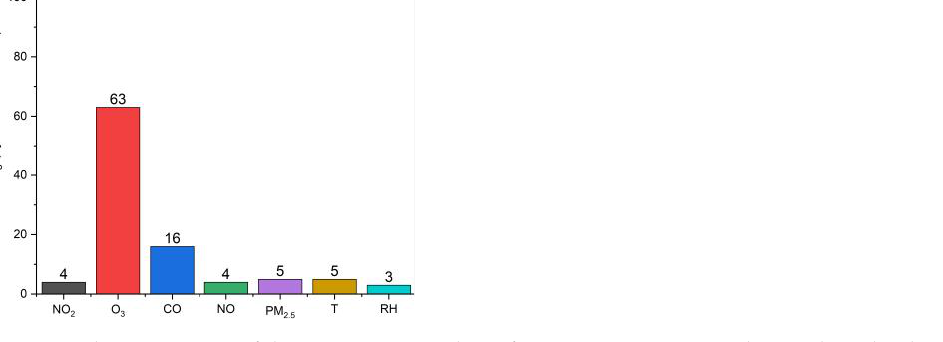
Figure 8. The importance of the ENSENSIA readings for correcting O 3 using the RF algorithm based on the training set (2021).